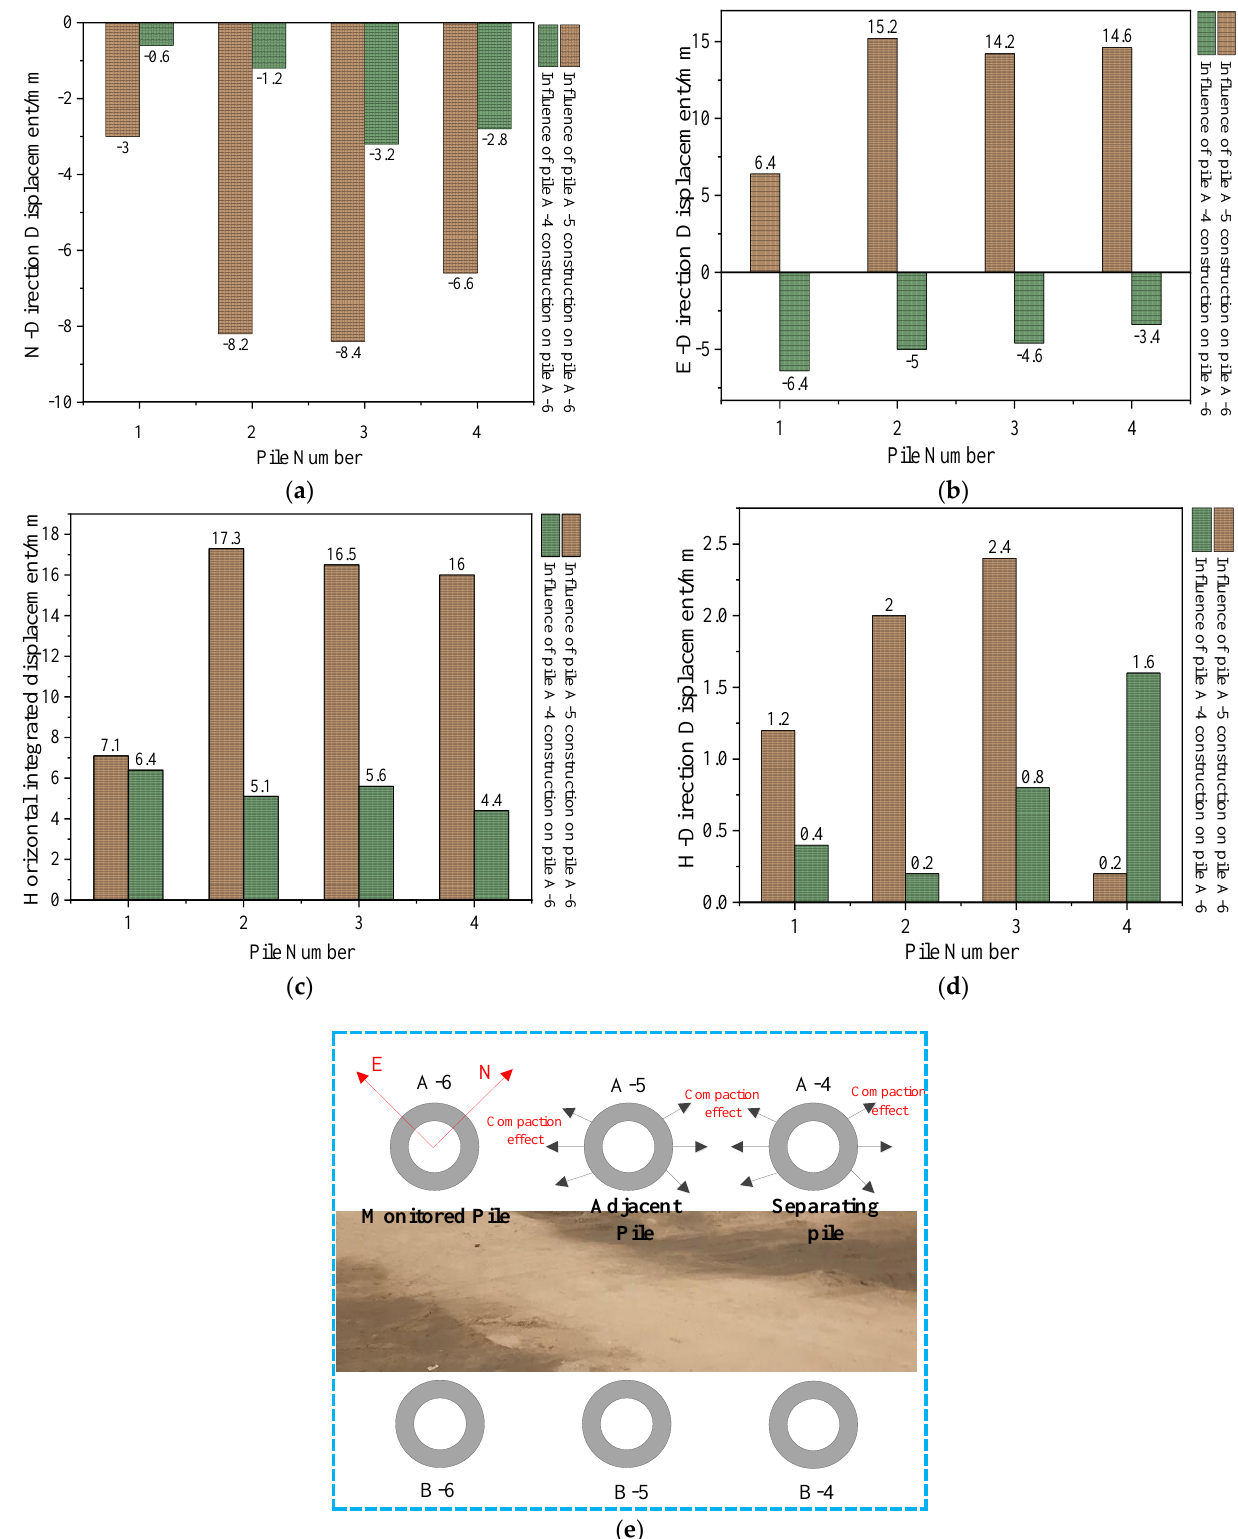
Figure 13. Representation of space displacement and compaction effect, showing the ( a ) schematic diagram of N-direction displacement, ( b ) schematic diagram of E-direction displacement, ( c ) schematic diagram of horizontal displacement, ( d ) schematic diagram of H-direction displacement, and ( e ) relationship between compaction effect and space displacement. Table 5. Movement value of the monitored pile (A-6).